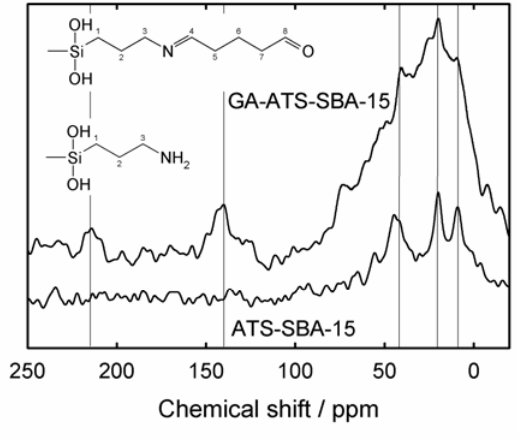
Figure 4. 13 C-CP-MAS - NMR spectra of ATS-SBA-15 and